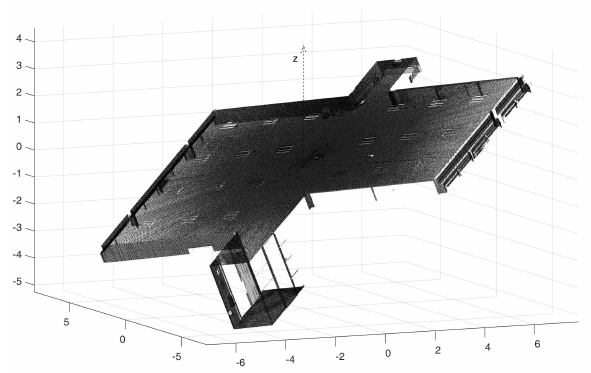
Figure 1: Input point cloud.